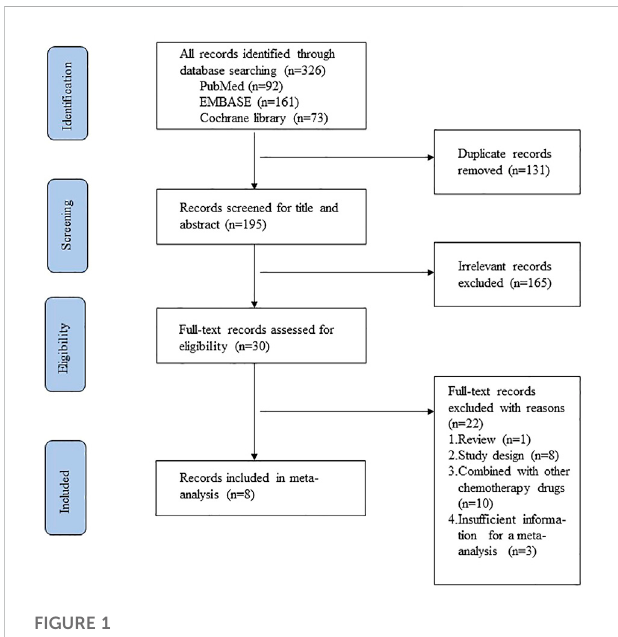
FIGURE 1 Selection process for eligible research.